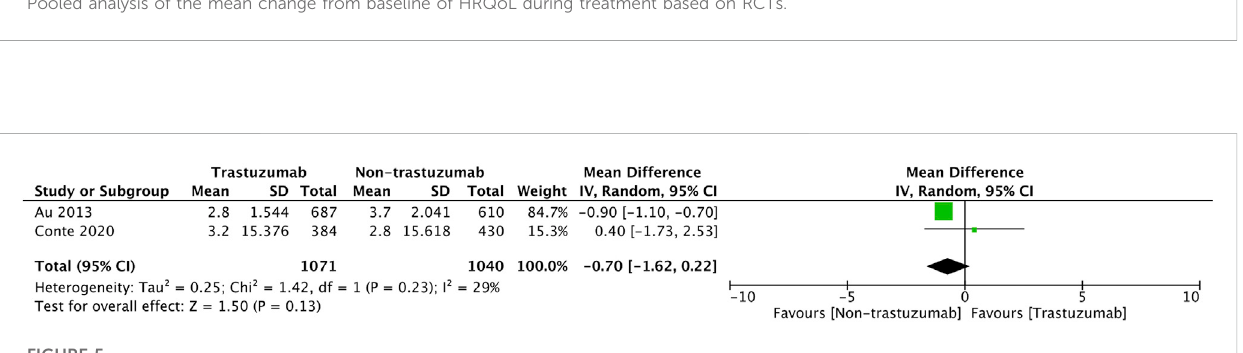
FIGURE 4 Pooled analysis of the mean change from baseline of HRQoL during treatment based on RCTs.